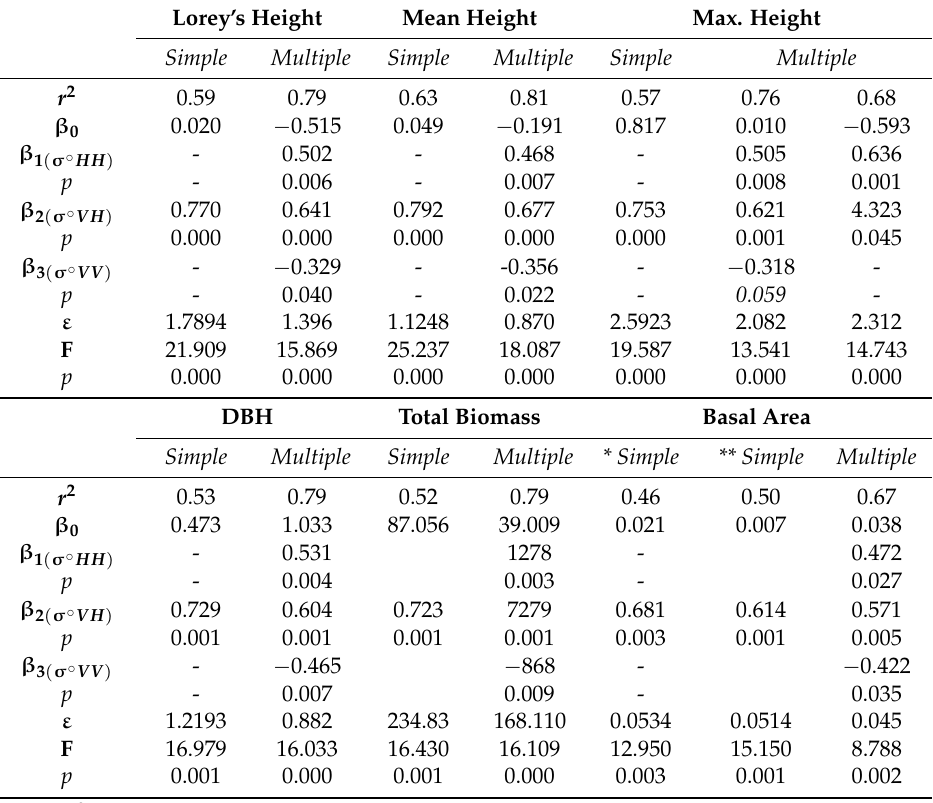
Table 7. Parameters of the simple and multiple regression models and σ ˝ HH, σ ˝ VH, and σ ˝ VV backscattering that compose the independent variables.